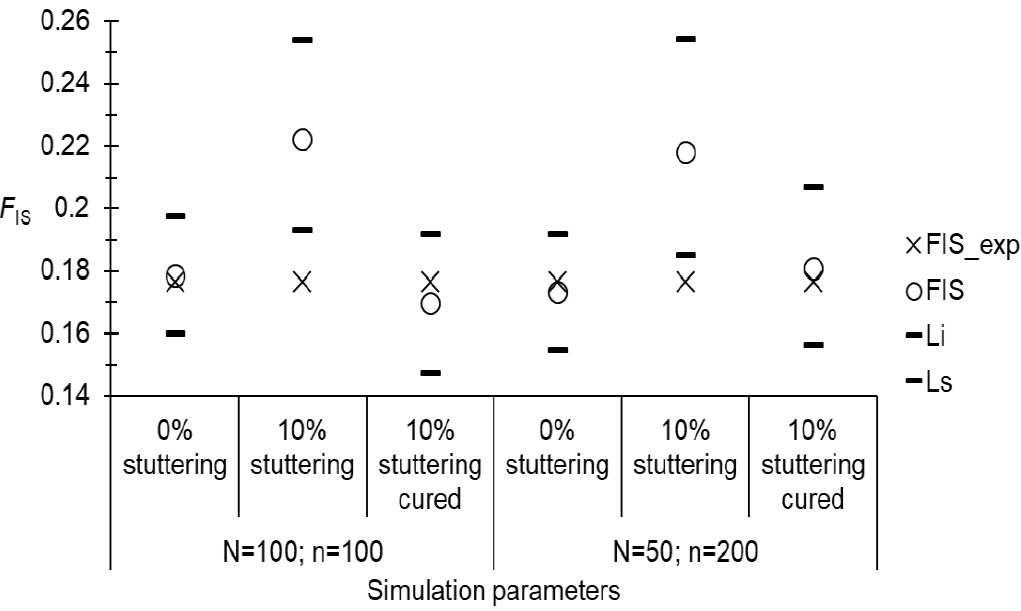
Figure 4: Comparison of Wright's F IS estimates obtained in different simulations in monoecious populations with 30% selfing, without stuttering, with 10% stuttering and with 10% stuttering cured data. The F IS_exp = s /(2- s ), is represented, as are the 95% bootstraps confidence intervals (Li and Ls) around observed